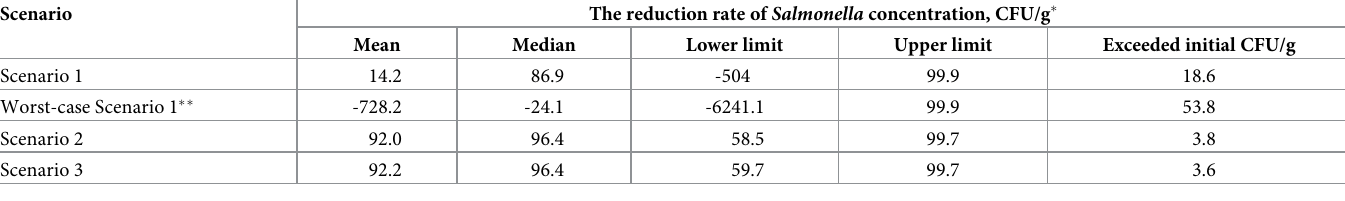
Table 6. Simulated reduction rate (percentage) of Salmonella concentration (CFU/g) in the RTE chicken salad in each scenario based on the experiment values sim- ulated 5000 times. Scenario